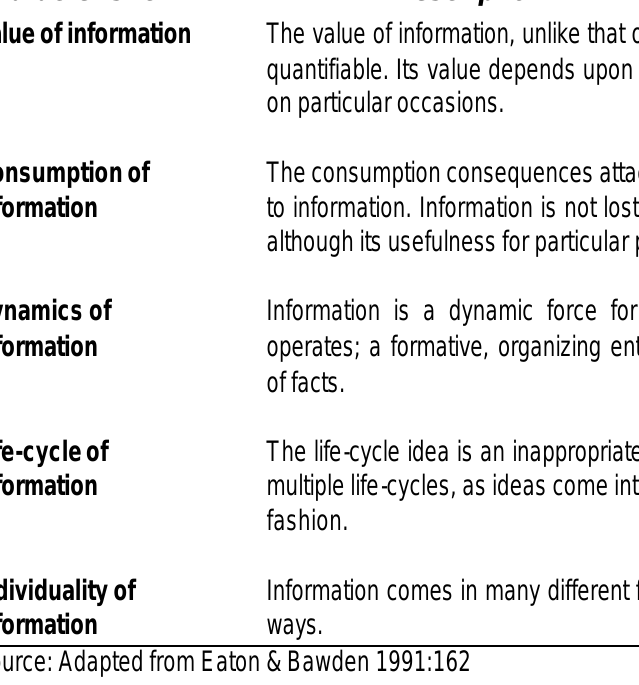
Table 2: THE DISTINCTION BETWEEN INFORMATION AND TANGIBLE RESOURCES Characteristic